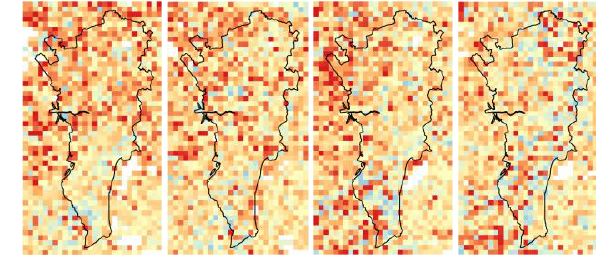
Figure 15. Sample PM 10 estimation maps using the best dry model for March 2017 to 2020.